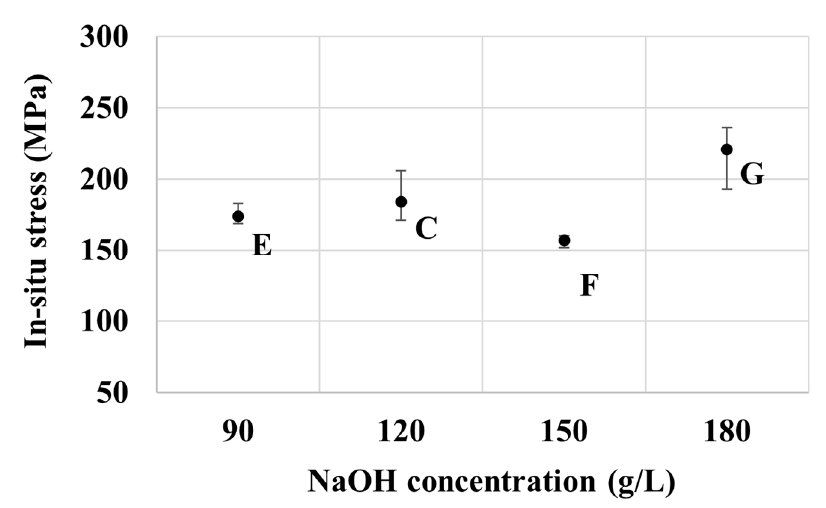
Figure 8. E ff ect of NaOH concentration on the in-situ internal stress of samples from baths E, C, F, and G.